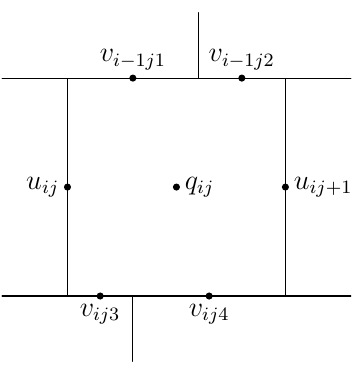
Figure 4. Discretization for zonal and meridional winds ( u and v , respectively) and tracer mixing ratio q .